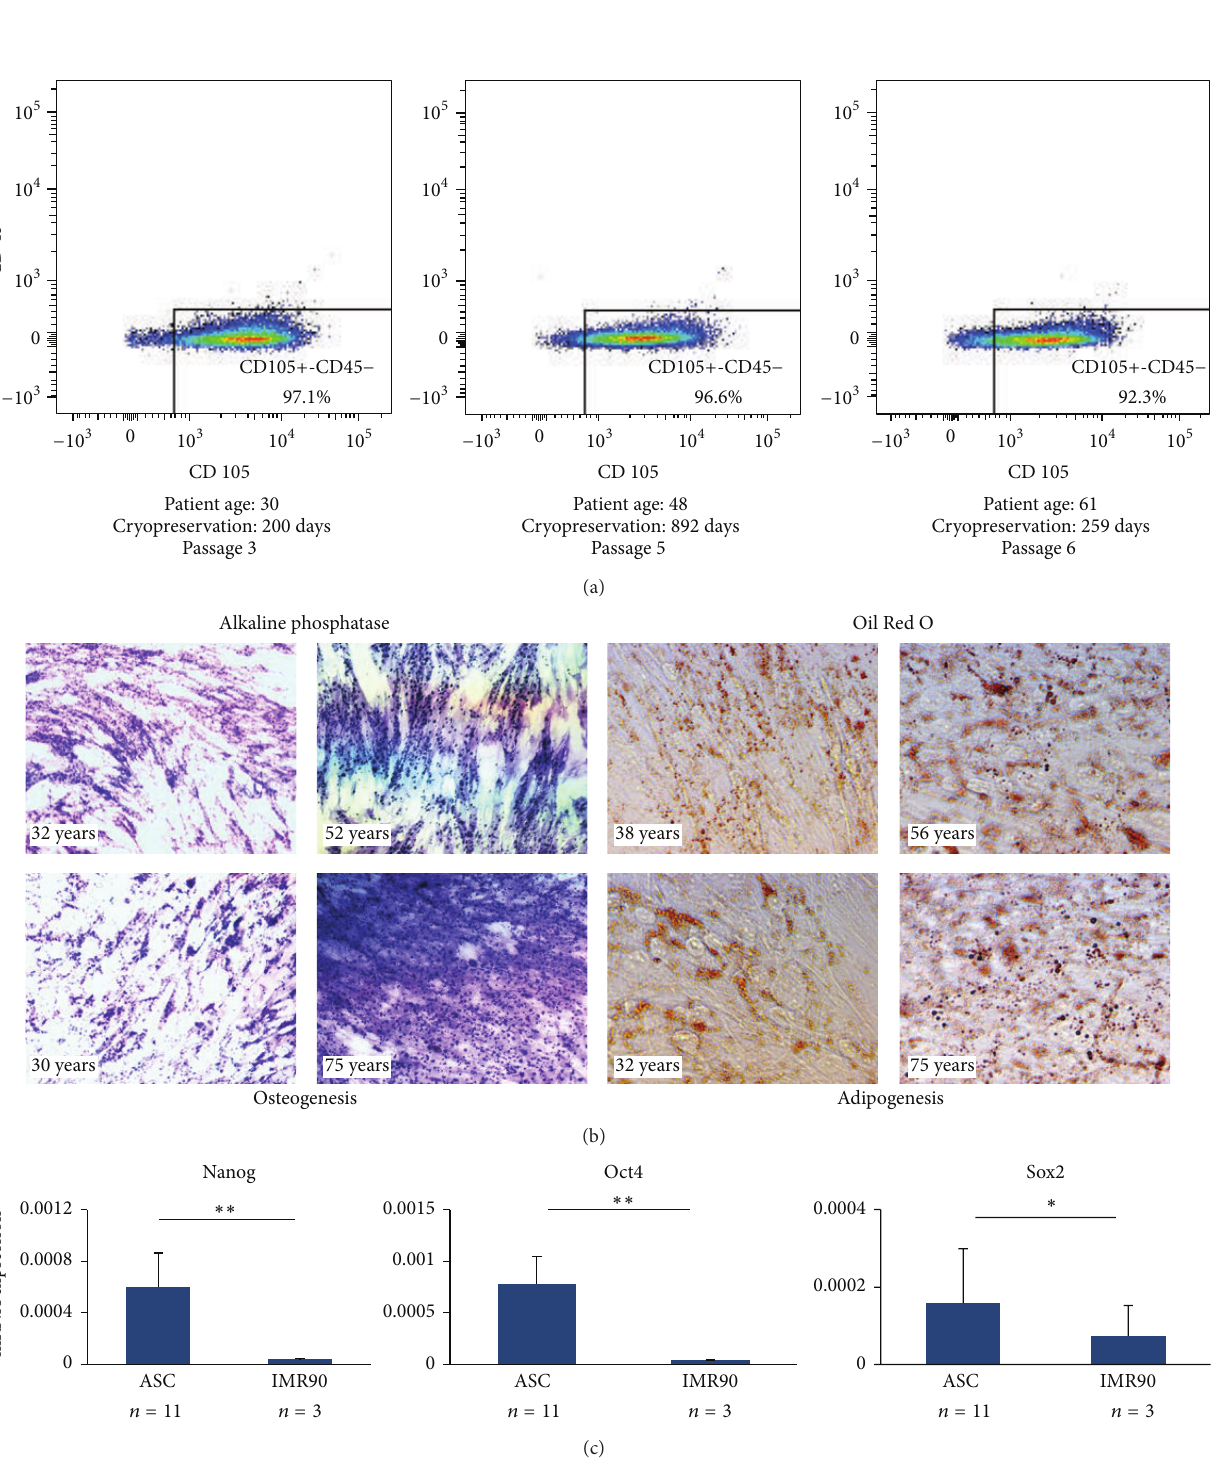
Figure 7: ASC phenotype confirmation. (a) ASCs were analyzed via FACS analysis for the following markers: CD105, CD34, and CD45. The data from representative patient cohorts are shown here. As predicted, the great majority of ASCs were CD105+ and CD45 − , while the CD34 marker showed variable expression (data not shown), consistent with prior studies. (b) ASCs isolated from all subgroups were capable of undergoing both osteogenic and adipogenic differentiation, as demonstrated by positive staining with alkaline phosphatase and Oil Red O, respectively. (c) Pluripotency gene expression was measured via qRT-PCR for Nanog, Sox2, and Oct4 and, as expected, was found to be higher in ASCs compared to terminally differentiated IMR90 cells. ∗ 𝑃 < 0.05 and ∗∗ 𝑃 < 0.01